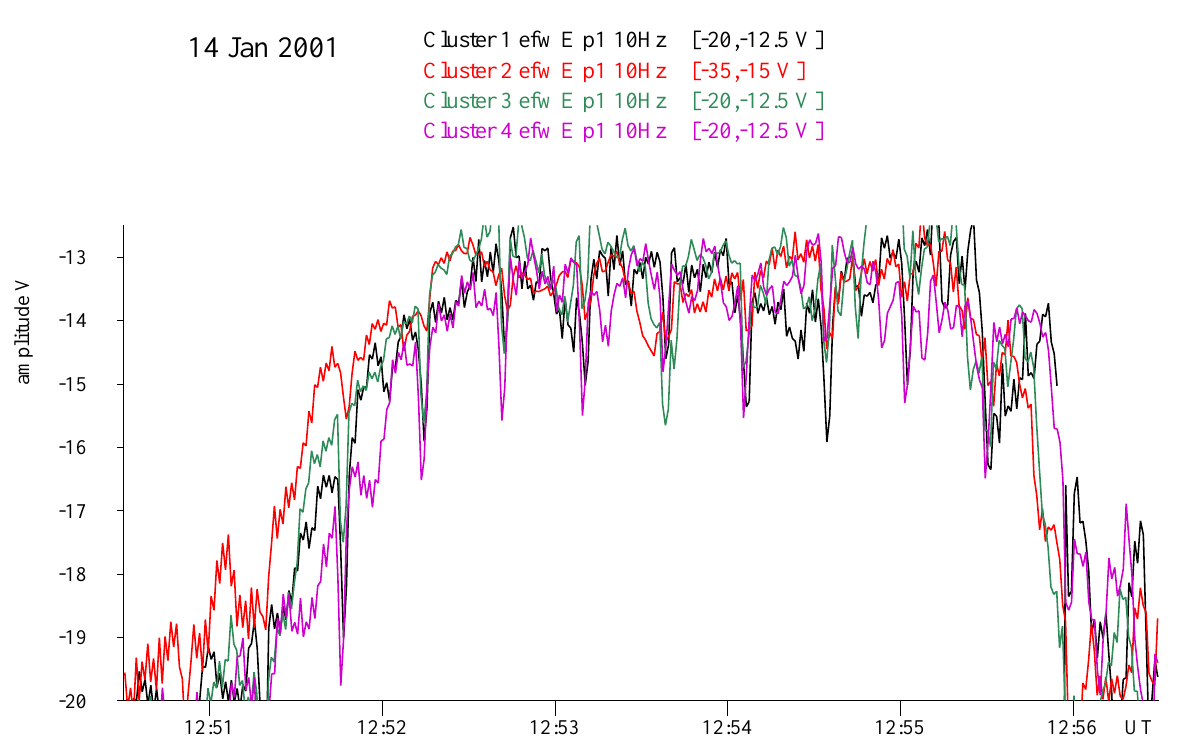
Fig. 9. High time resolution plots of the negative of the spacecraft potential of the four Cluster spacecraft during the BL-E1 encounter. The data points represent 1s averages. The scale of the potential of spacecraft 2 has been adjusted to be on the same level as the other three. Due to an unscheduled high beam current in the EDI experiment, this spacecraft was shifted to a lower potential. The periodic dips in the potential are due to the operation of the Whisper